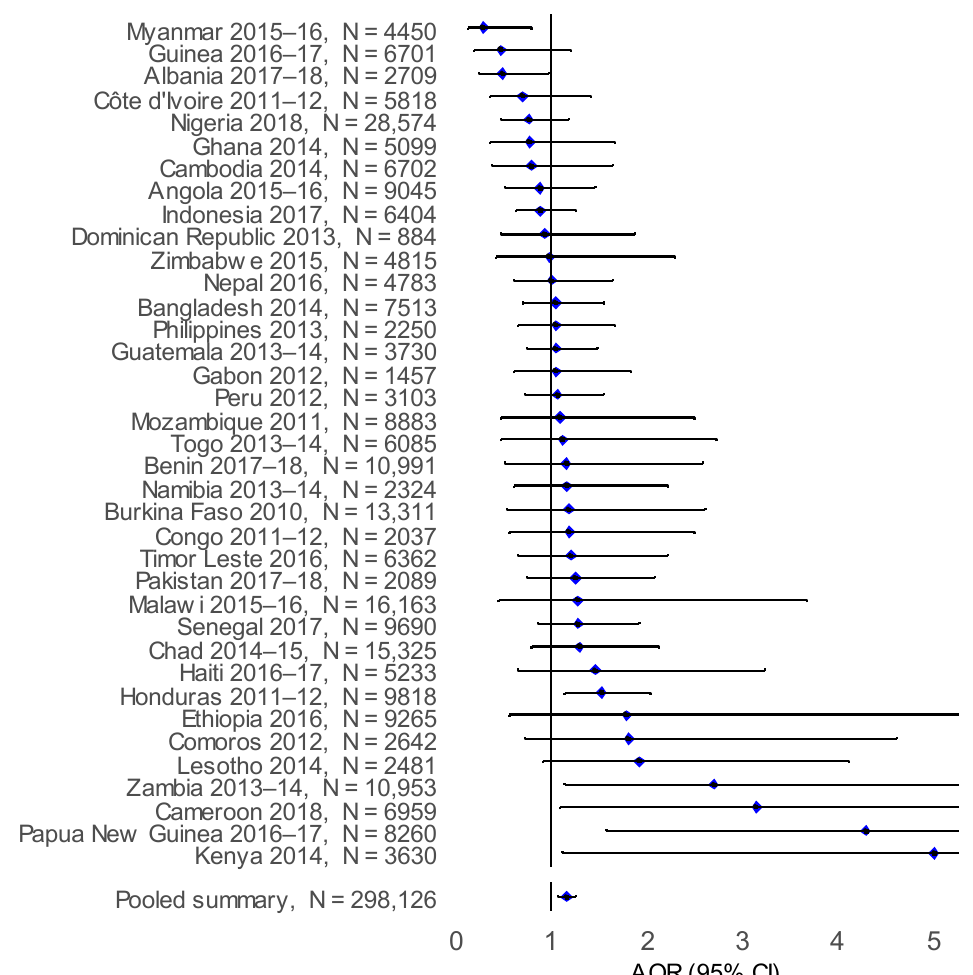
Figure 6. Forest plot for the adjusted odds ratio (AOR) for ALRI in children aged under five years with biomass cooking compared to cleaner cooking for all countries. Table 3. Adjusted odds ratio (AOR) with 95% CI for the association of ARI and ALRI in children aged under five years with biomass cooking compared to cleaner cooking for rural and urban